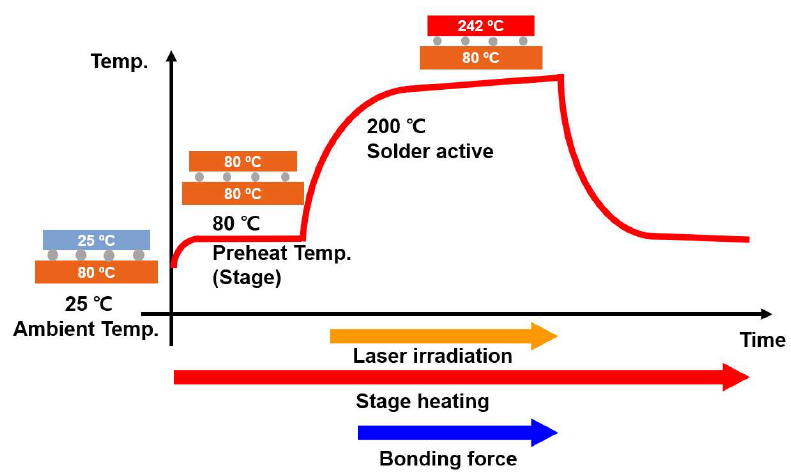
Figure 5. Temperature loading condition used in the numerical simulation.